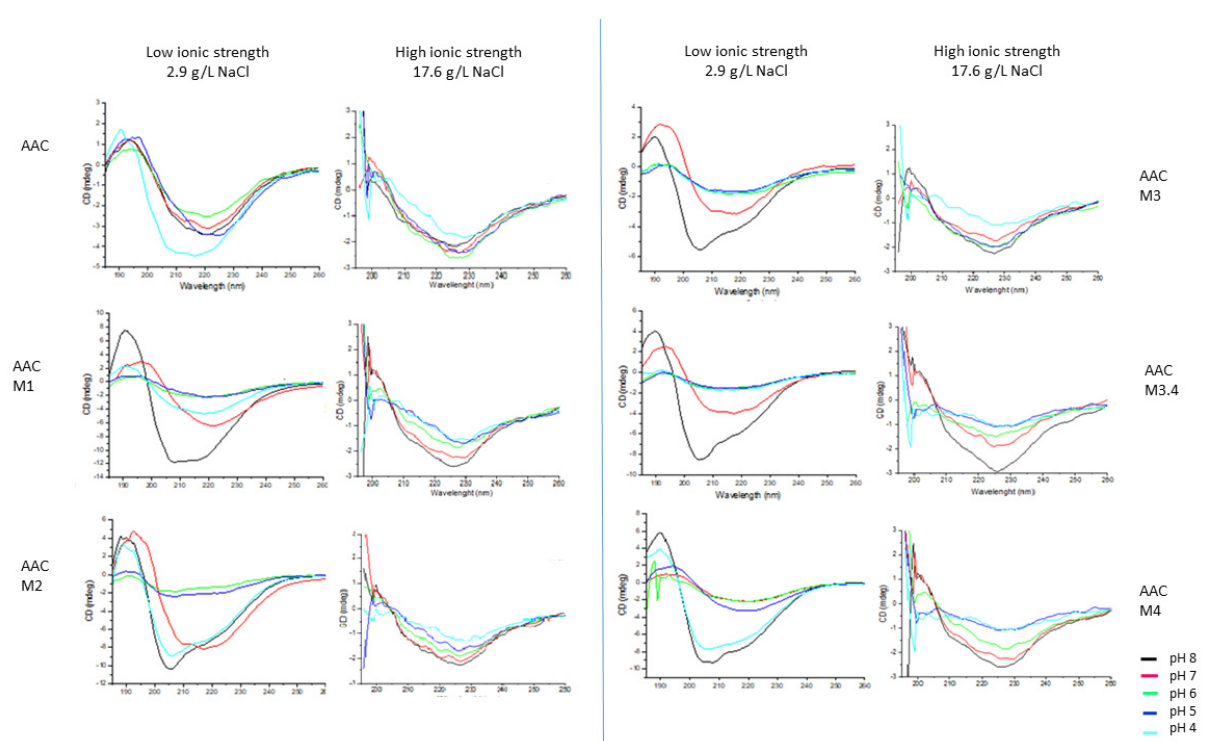
Figure 1. CD spectra of AAC and their modified polypeptides at different pH conditions, at low ionic strength and high ionic strength. pH 8: black; pH 7: red; pH 6: green; pH 5: blue; pH 4: cyan.